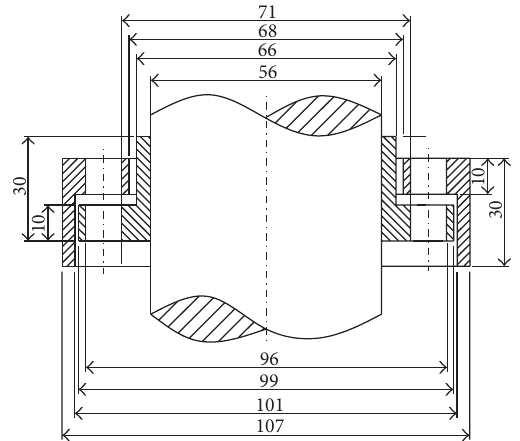
Figure 5: Part of the design